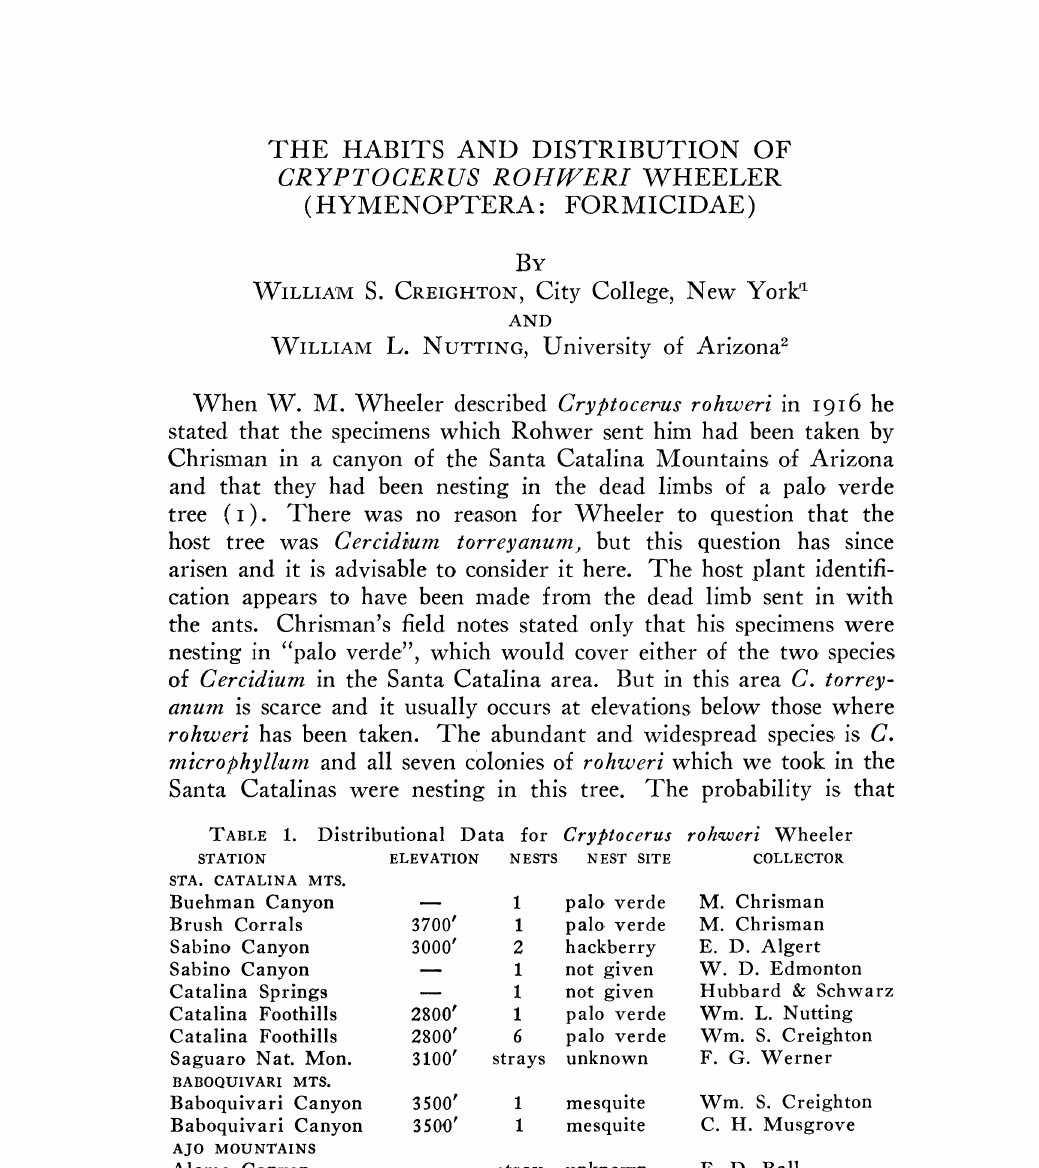
Distributional Data for Cryptocerus roheri Wheeler ELEVATION STA. CATALINA MTS. Buehman Canyon Brush Corrals Sabino Canyon Sabino Canyon Catalina Springs Catalina Foothills Catalina Foothills Saguaro Nat. Mon. BABOQUIVARI MTS. Baboquivari Canyon Baboquivari Canyon AJO MOUNTAINS Alamo Canyon ATASCOSA MTS. Pefia Blanca Sprs.